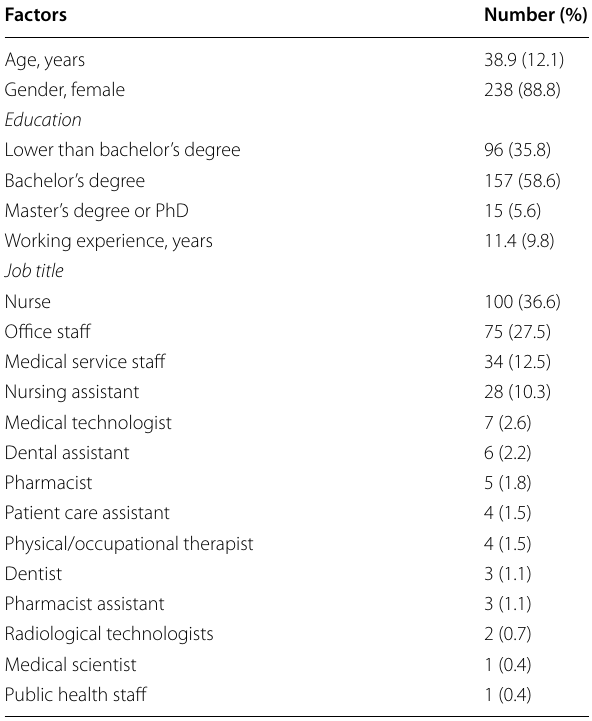
Table 1 Characteristics of healthcare workers who participated